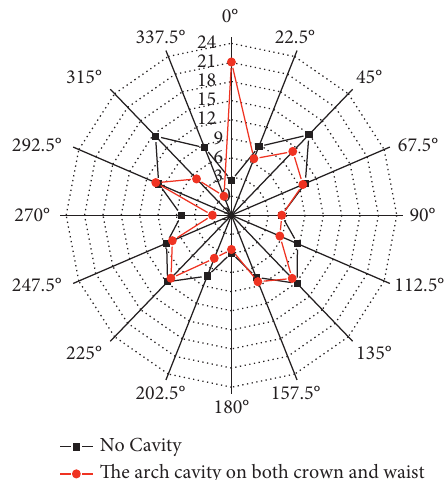
Figure 21: Safety coefficient of the segment cross section of the cavity behind the vault and arch waist.